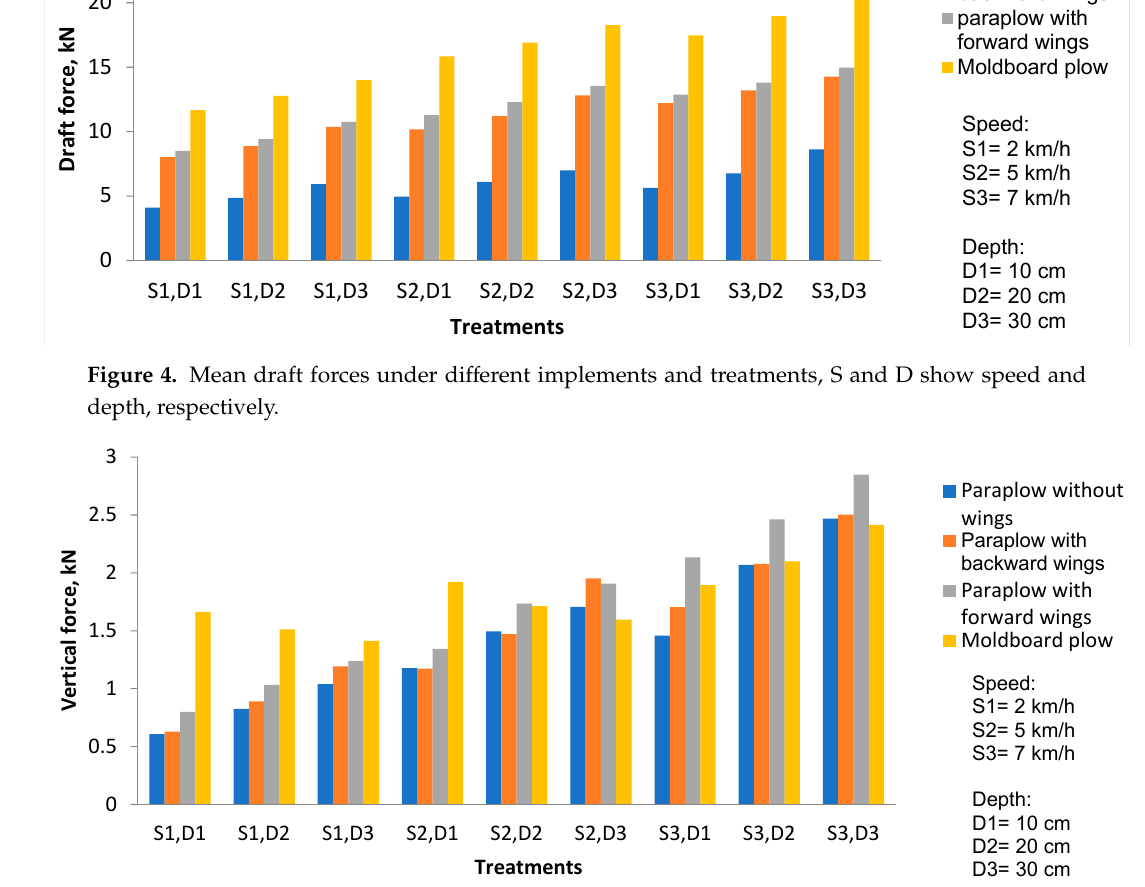
Figure 5. Mean vertical forces under different implements and treatments, S and D show speed and depth, respectively.